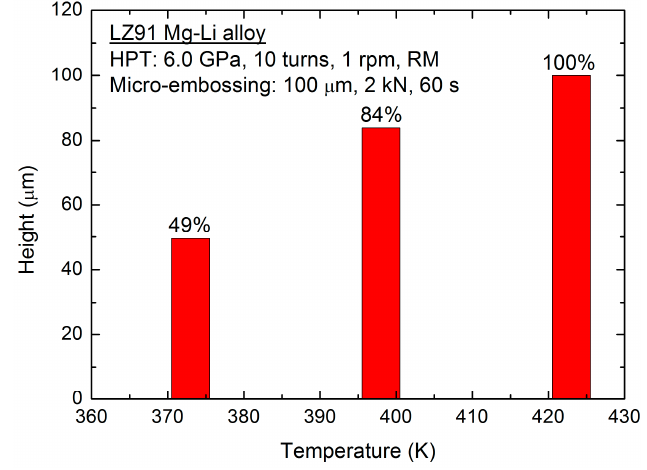
Figure 6. Filling height after micro-embossing with an increasing applied temperature.